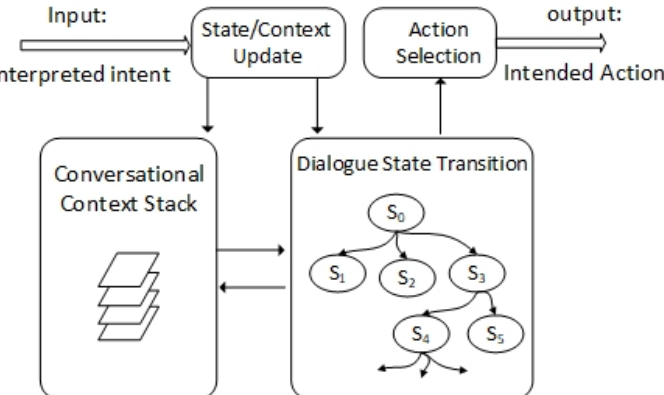
Figure 2. Information flow of dialogue management